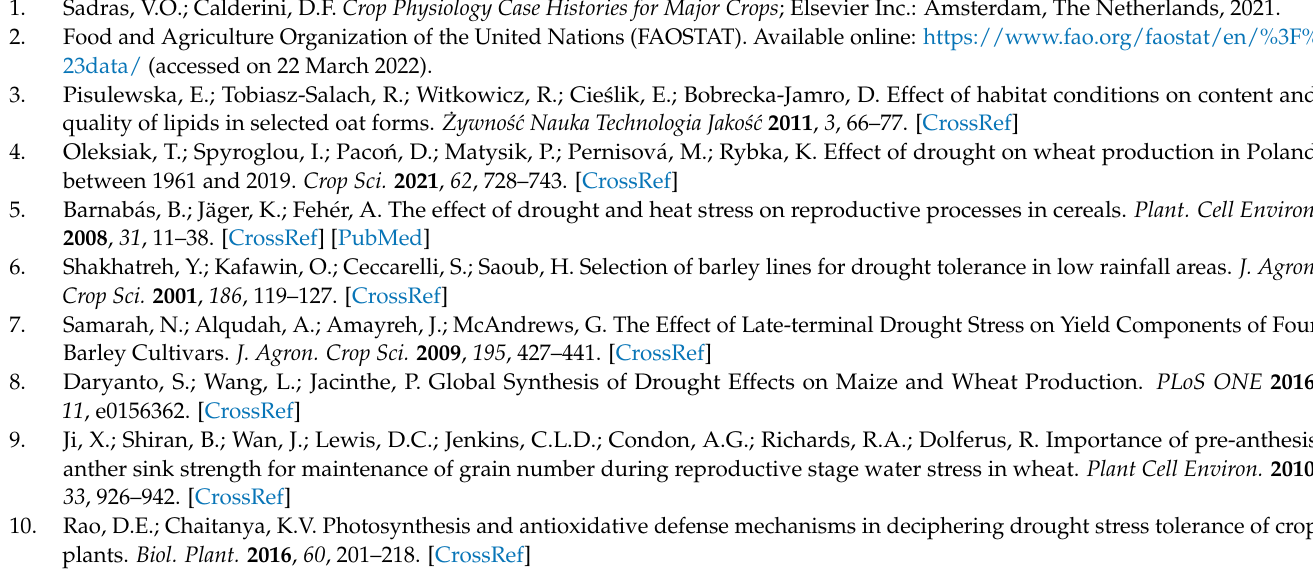
drought. Table S9: Mean values, standard deviations and Fisher’s least significant differences (LSDs) for RC/CSo (number of active reaction centres in the state of fully oxidized PSII reaction center) in the first day of drought. Table S10: Mean values, standard deviations and Fisher’s least significant differences (LSDs) for chlorophyll a content ( µ g/g of d.w.) after two weeks of drought. Table S11: Mean values, standard deviations and Fisher’s least significant differences (LSDs) for chlorophyll b content ( µ g/g of d.w.) after two weeks of drought. Table S12: Mean values, standard deviations and Fisher’s least significant differences (LSDs) for chlorophyll a and chlorophyll b content ( µ g/g of d.w.) after two weeks of drought. Table S13: Mean values, standard deviations and Fisher’s least significant differences (LSDs) for carotenoids content ( µ g/g of d.w.) after two weeks of drought. Table S14: Mean values, standard deviations and Fisher’s least significant differences (LSDs) for Fv/Fm (maximum photochemical efficiency of PS II) after two weeks of drought. Table S15: Mean values, standard deviations and Fisher’s least significant differences (LSDs) for area (pool size of electron acceptors from PSII) after two weeks of drought. Table S16: Mean values, standard deviations and Fisher’s least significant differences (LSDs) for PI (overall performance index of PSII photochemistry) after two weeks of drought. Table S17: Mean values, standard deviations and Fisher’s least significant differences (LSDs) for ETo/CS (energy used for electron transport) after two weeks of drought. Table S18: Mean values, standard deviations and Fisher’s least significant differences (LSDs) for RC/CSo (number of active reaction centres in the state of fully oxidized PSII reaction center) after two weeks of drought. Table S19: Mean values, standard deviations and Fisher’s least significant differences (LSDs) for the mass of stems/plant (g). Table S20: Mean values, standard deviations and Fisher’s least significant differences (LSDs) for the number of grains. Table S21: Mean values, standard deviations and Fisher’s least significant differences (LSDs) for the mass of grains/plant